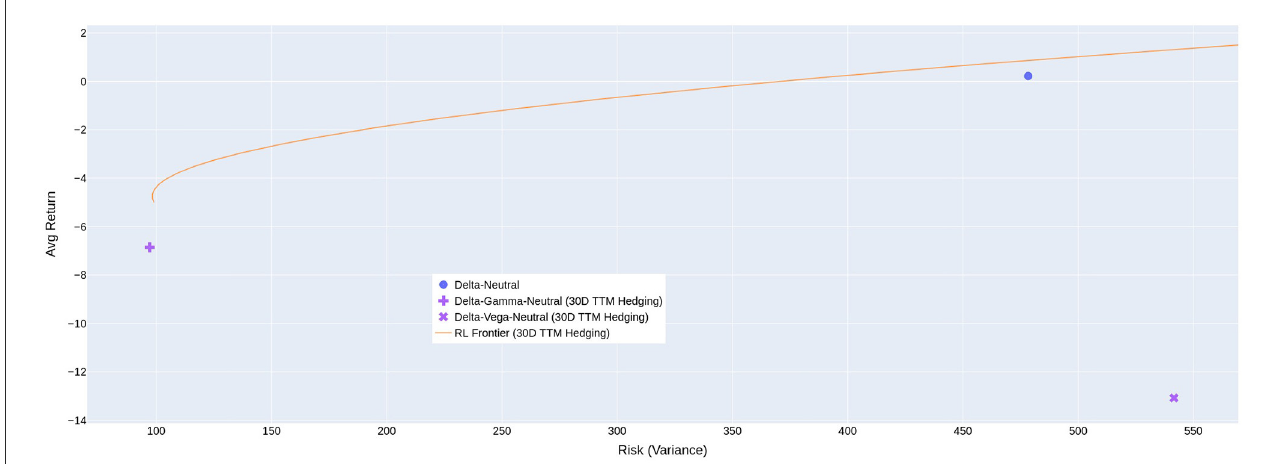
FIGURE3 Risk-return trade-offs that are possible using RL with different objective functions. The positive average cost of hedging reported in previous tables means the average return of the agent is